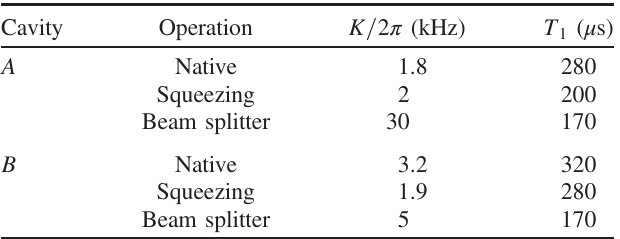
TABLE V. Estimated cavity Kerr and T 1 values. The beam splitter decay rates are extracted from the fit performed in the calibration of the operation in Fig. 4(c) assuming that κ